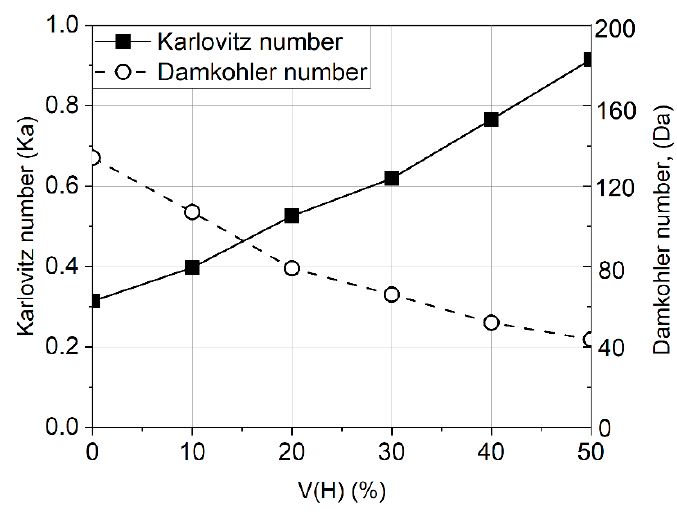
Figure 15. Karlovitz and Damköhler numbers for hydrogen volume fraction [31].